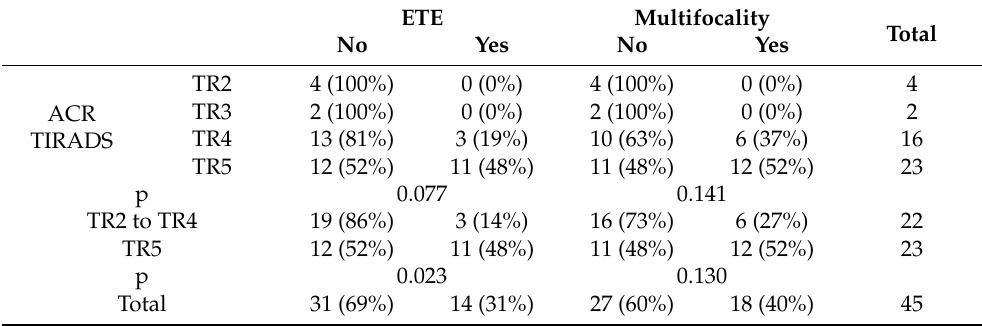
Table 5. Extrathyroidal extension and multifocality according to ACR TIRADS